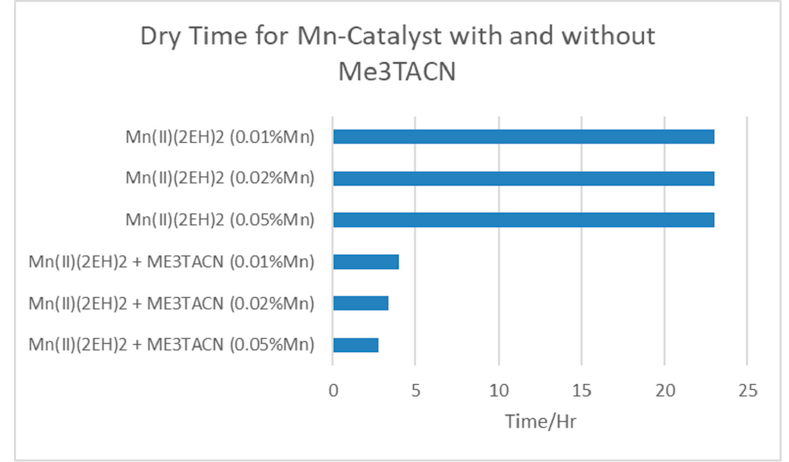
Figure 9. Surface drying activity (denoted in blue) of various level of Mn II (2-EH) 2 and Mn II (2-EH) 2 premixed with molar equivalent of Me 3 TACN (1,4,7-trimethyl-1,4,7-triazacyclononane). This data set was obtained from a formulated commercial alkyd.